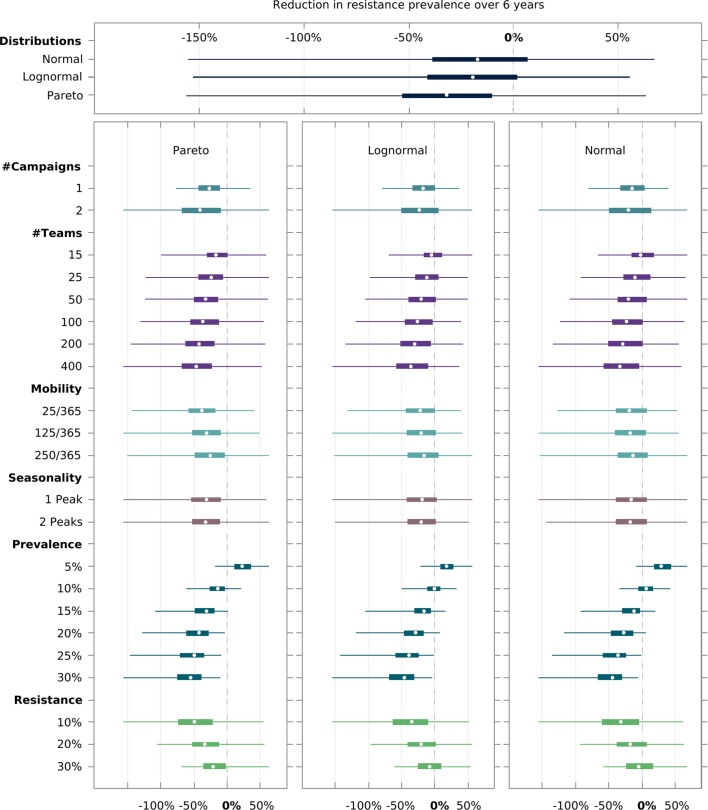
Factors influencing the spread of artemisinin resistance.In all similar to Figure 2, it shows how the different model parameters modulate the predicted proportional decrease in artemisinin resistance after MDA. Negative numbers then reflect a rise in artemisinin resistant infections from start of the campaign to the end of the simulation (a −100% value indicates a 2-fold increase in the number of resistant parasites).